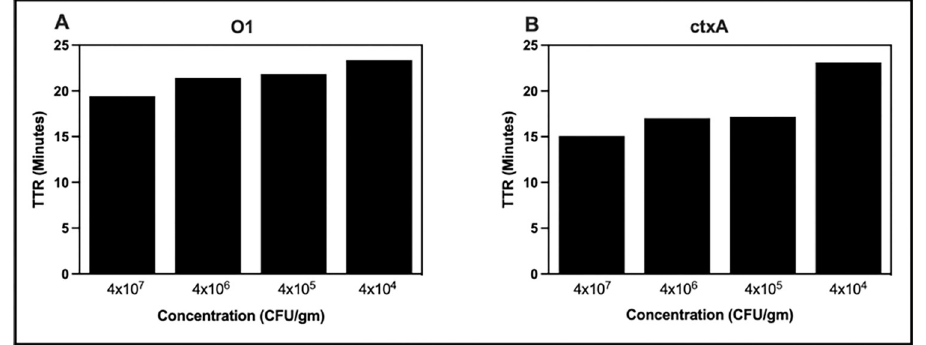
Fig 5. Lowest Detection Limit (LOD) of cholera RLDT from dried stool on filter paper. Stool samples were spiked with ten-fold serial dilutions of V . cholerae N16961and 50 uL of each dilution was spotted on filter paper. The stool spots were processed and tested with an RLDT kit. LOD was determined. A: O1 rfb gene; B: ctxA gene.